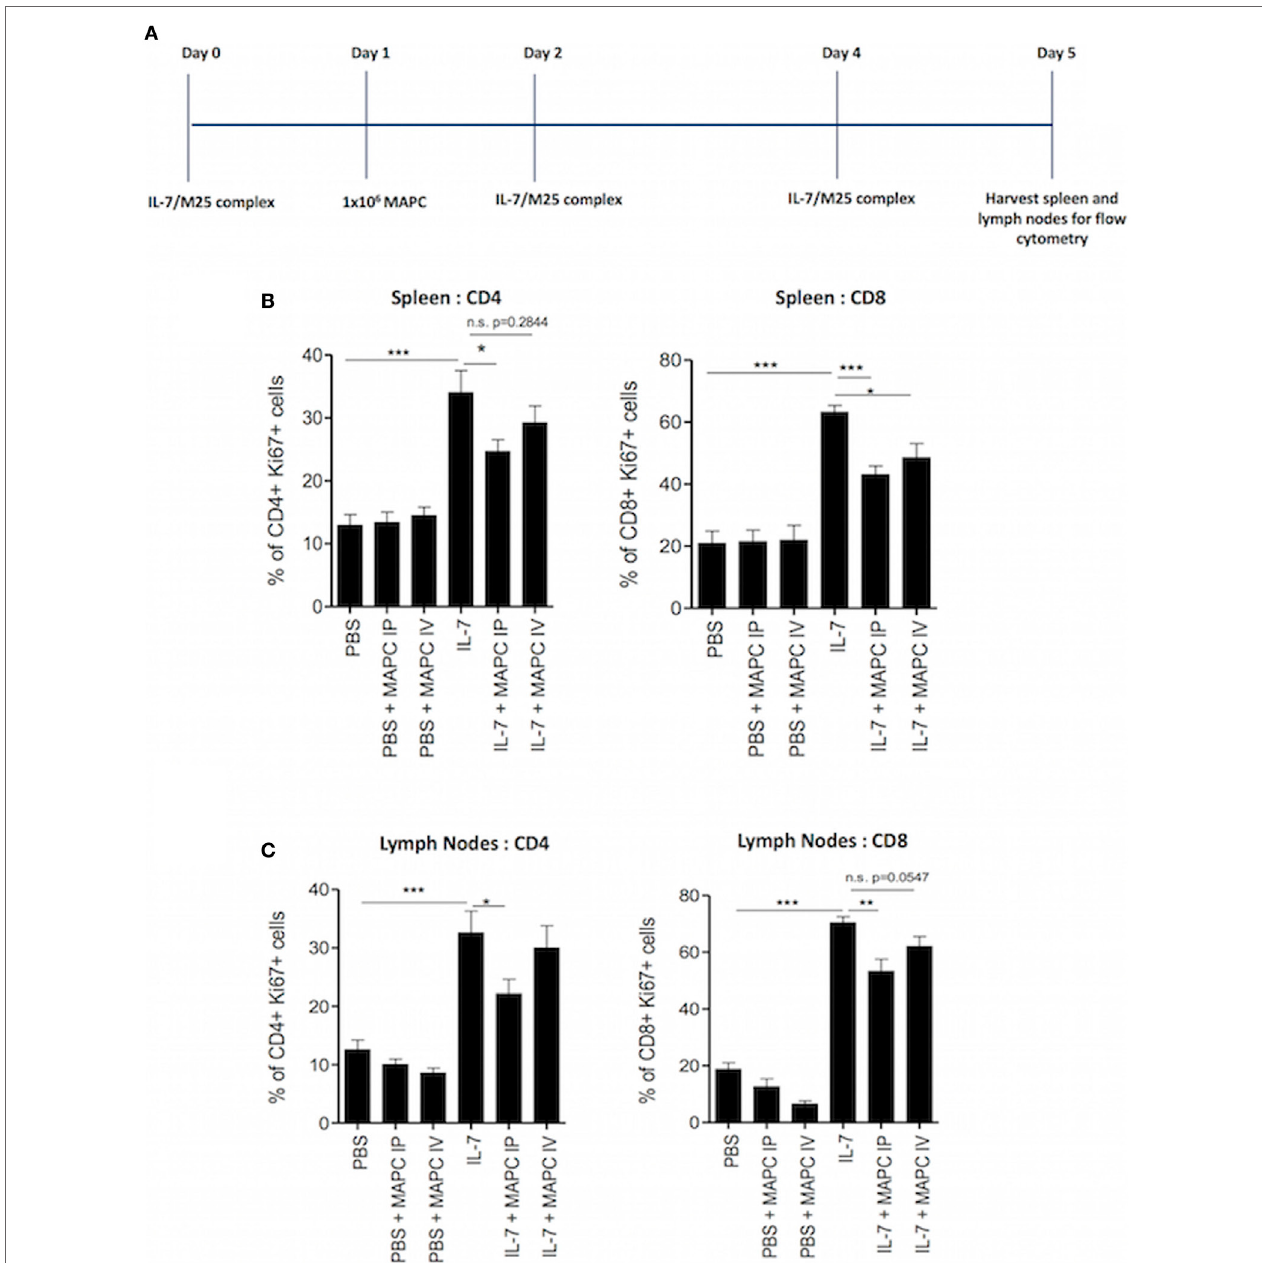
FigUre 1 | Multipotent adult progenitor cells (MAPC) suppress IL-7-driven proliferation of T cells in vivo . (a) Schematic timeline of IL-7-driven homeostatic proliferation experiments. Recombinant IL-7 conjugated to M25 or PBS was administered intraperitoneally (IP) on days 0, 2, and 4. 1 × 10 6 MAPC cells were administered IP or intravenously (IV) on day 1. Lymph nodes and spleens were harvested on day 5. (B) Bar graphs demonstrating that both MAPC IV and MAPC IP reduce the frequency of Ki67 + CD4 + and CD8 + cells in the spleen (PBS: n = 13, PBS + MAPC IP: n = 17, PBS + MAPC IV: n = 13, IL-7: n = 12, IL-7 + MAPC IP: n = 17, and IL-7 + MAPC IV: n = 13) (c) Bar graphs demonstrating that MAPC IP but not MAPC IV reduce the frequency of Ki67 + CD4 + and CD8 + T cells in the lymph nodes (PBS: n = 12, PBS + MAPC IP: n = 15, PBS + MAPC IV: n = 13, IL-7: n = 12, IL-7 + MAPC IP: n = 17, and IL-7 + MAPC IV: n = 13). Results are indicative of three independent experiments using three MAPC donors * p < 0.05, ** p < 0.01, and *** p <